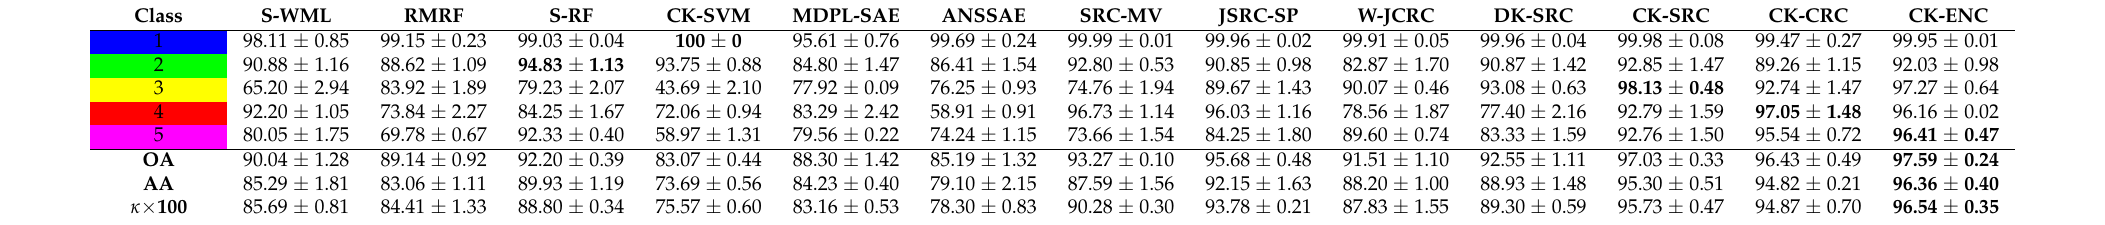
Table 4. Comparision of classification performances on the San Franciso